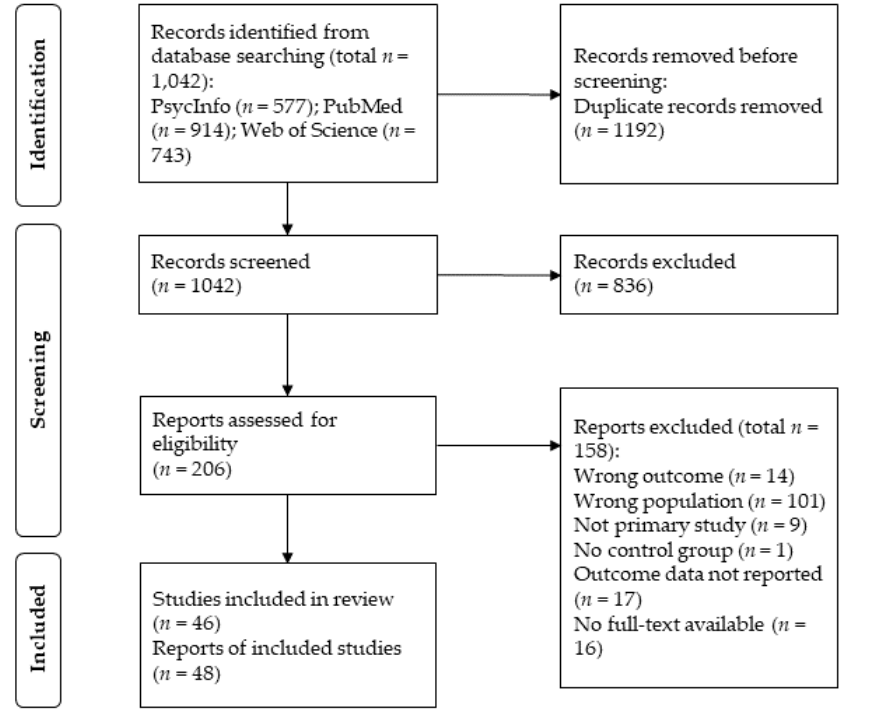
Figure 1. Study selection process.